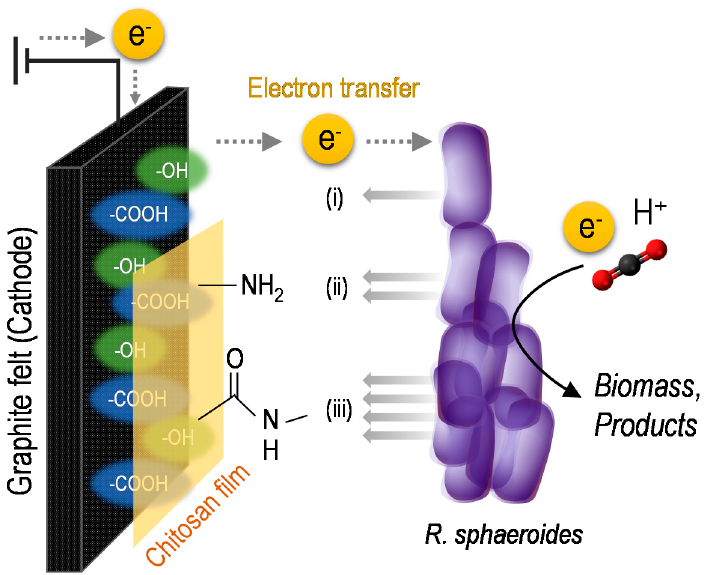
Figure 1. Schematic illustration of the proposed mechanisms of bacterial adsorption ( Rhodobacter sphaerodies ) onto the graphite felt electrode (GFE). (i) Bacterial adsorption onto the bare (GFE), (ii) chitosan-modified (GFE/Chit), and (iii) chitosan/carbodiimide compound-modified (GFE/Chit/CDI) cathode. Electron and proton (H + ) sources for microbial CO 2 conversion of R. sphaeroides can be supplied from the cathode part via the anodic water splitting reaction.